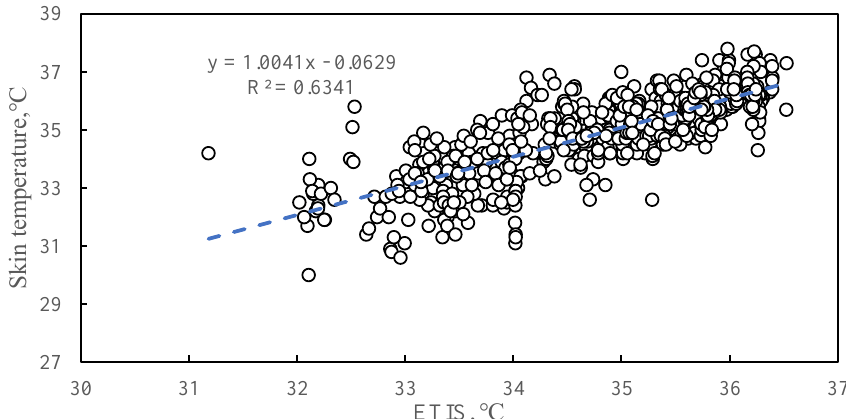
Figure 5. Regression of equivalent temperature index for sows to skin temperature based on training data. The dots represent the scatter plot of the skin temperature of the sow corresponding to the ETIS. The dotted line represents the model estimate based on the linear regression of sow skin tem- perature with 720 ETIS training data. The linear regression equation here is: y = 1.0041x − 0.0629 (where y stands for skin temperature (°C) and x stands for ETIS (°C)) (R 2 = 0.6341, p < 0.0001).